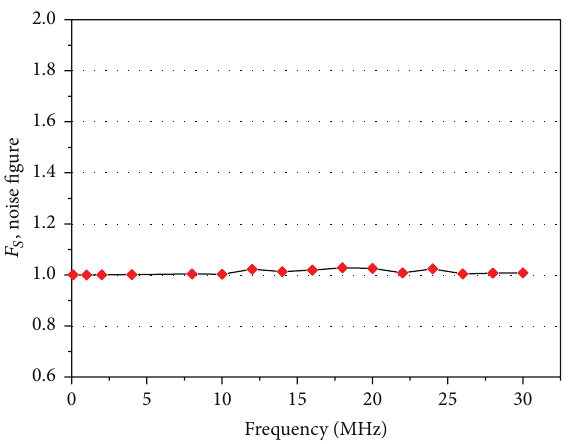
Figure 11: Ratio of 𝐹 𝑠 to the noise factor variation with frequency.